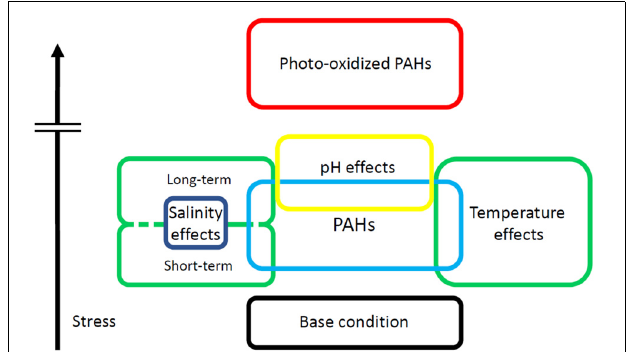
FIGURE 1 | The PAH-induced stress hierarchy. PAHs induce bodily stress above that of normal uncontaminated conditions. Salinity and Temperature may add to or mitigate the stress of PAH-burden. Photo-oxidized PAHs are far more toxic than their parent PAHs, and their increased potential to cause harm is represented by the break in the vertical